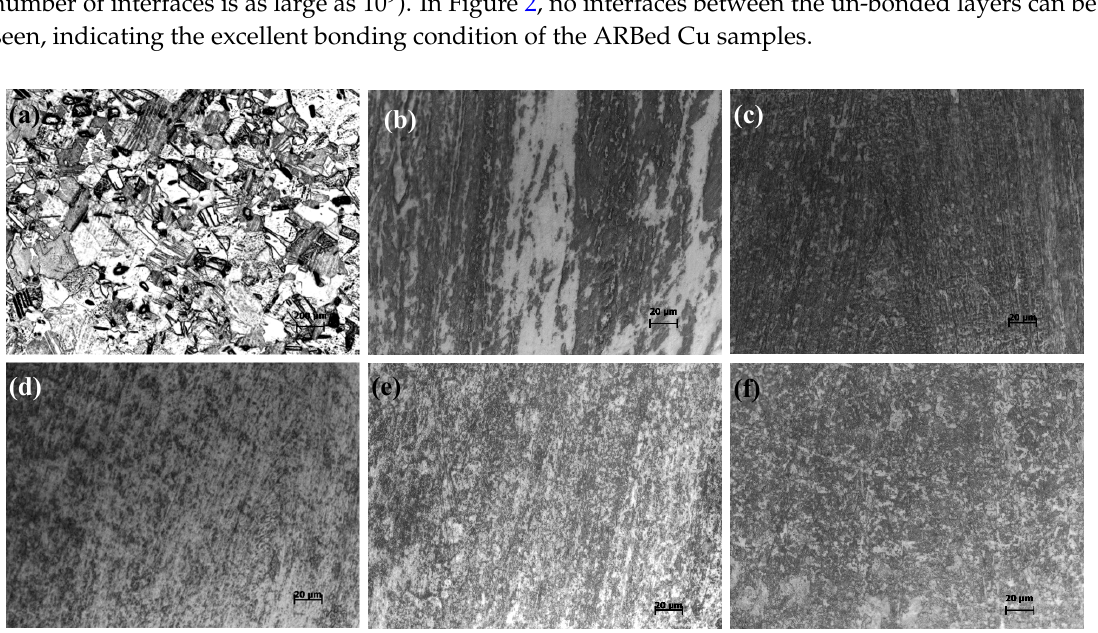
Figure 2. Micrographs of ( a ) annealed Cu before ARB, RD ‐ ND planes of ARBed Cu samples with N = ( b ) 1, ( c ) 5, ( d ) 10, ( e ) 20 and ( f ) 30.